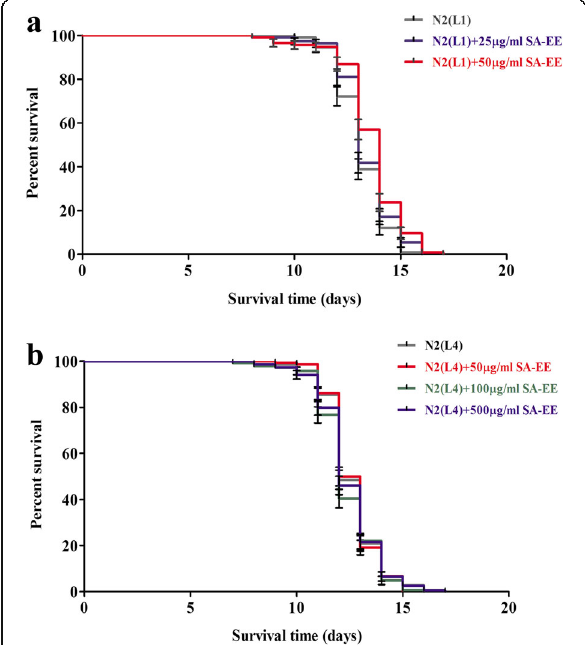
Fig. 6 Effect of SA-EE on lifespan in C. elegans. Cumulative survival plots of wild-type N2 C. elegans at L1 ( a ) and L4 larval stages ( b ) grown at 25 °C treated with different concentrations of SA-EE or DMSO in control group. All data are shown as the mean±SD from three independent experiments